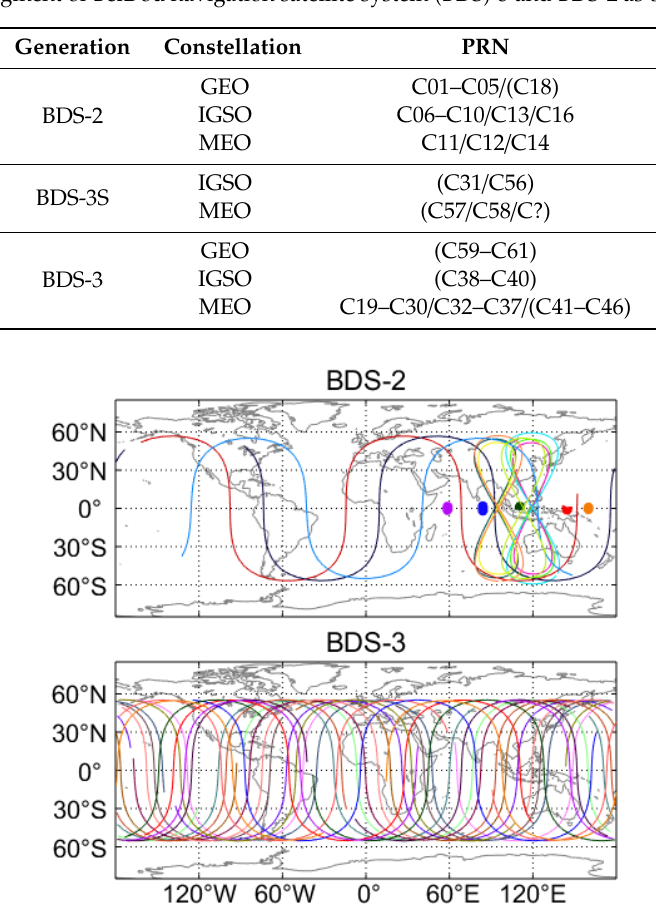
Figure 1. Ground track of BDS-2 and BDS-3 satellites on day of the year (DOY) 140, 2020. Different colors in the figure refer to different satellites.